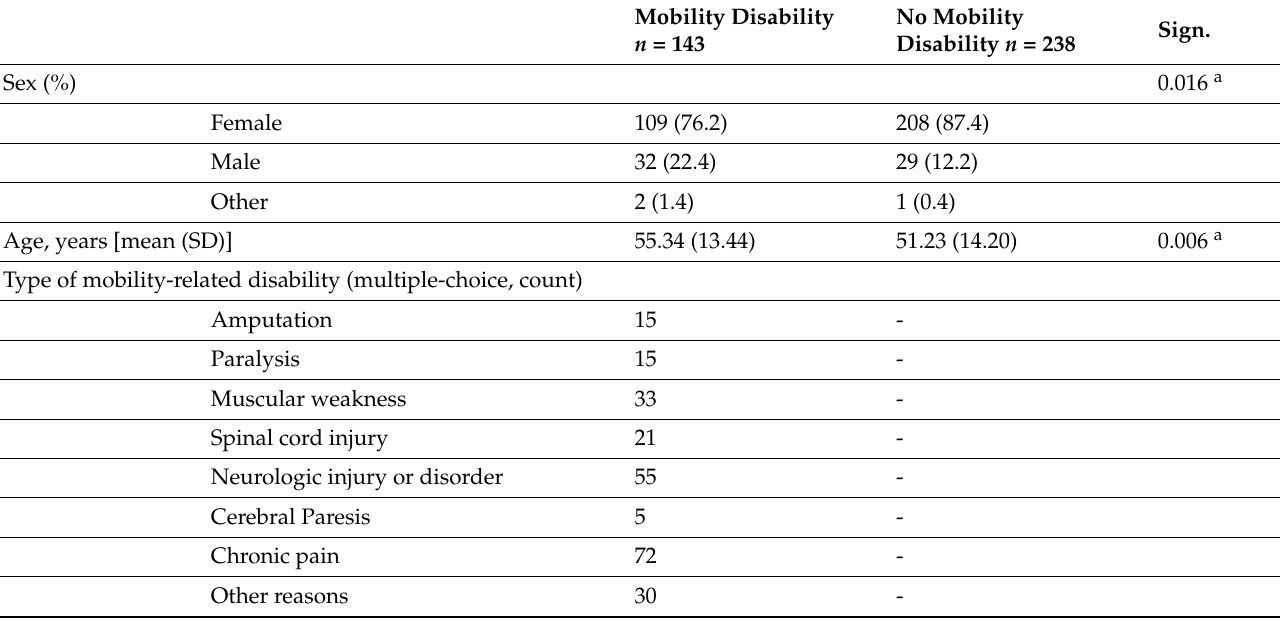
Table 1. Characteristics of the study